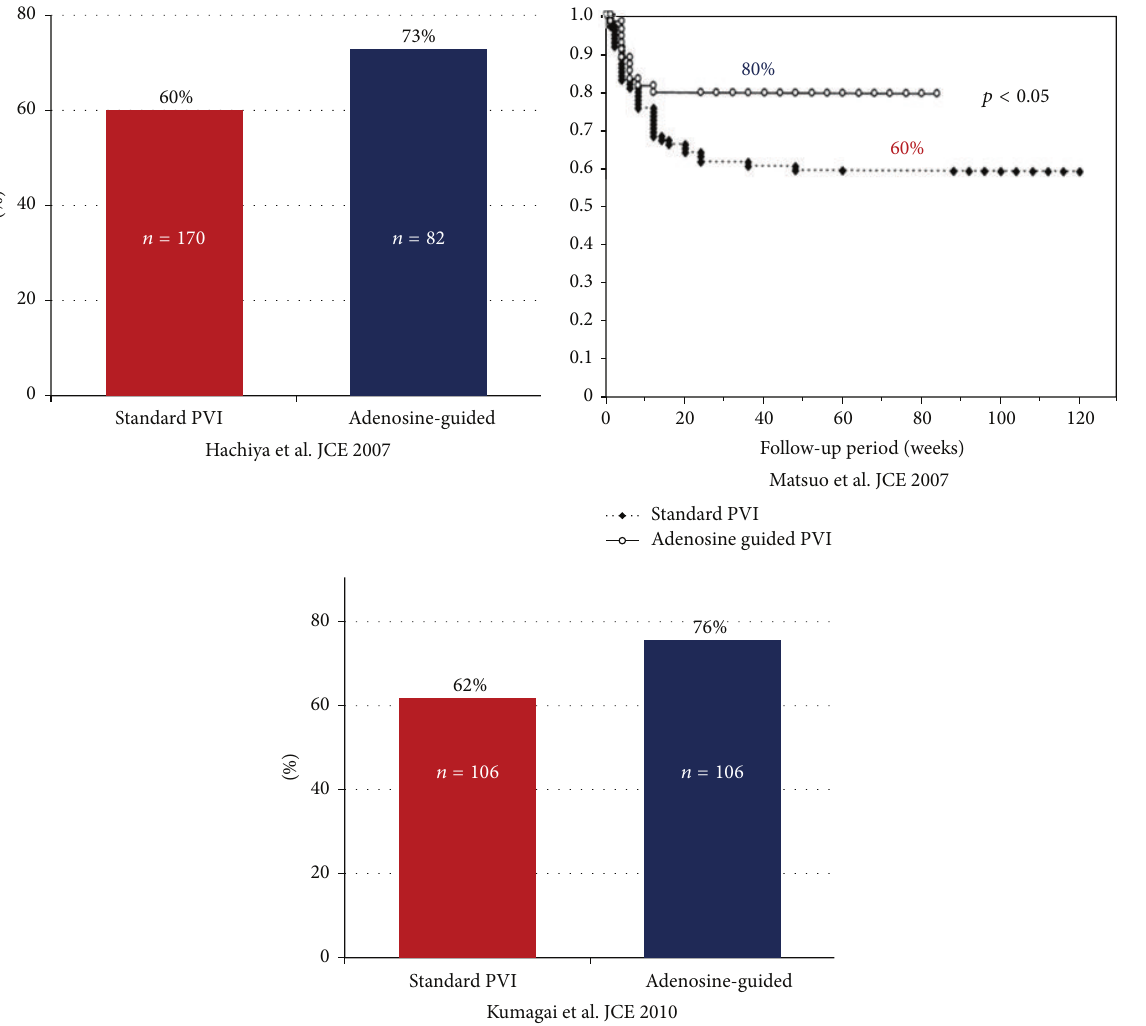
Figure 2: Freedom from AF in three nonrandomized retrospective studies comparing adenosine given versus adenosine not given [12–14]. PVI: pulmonary vein